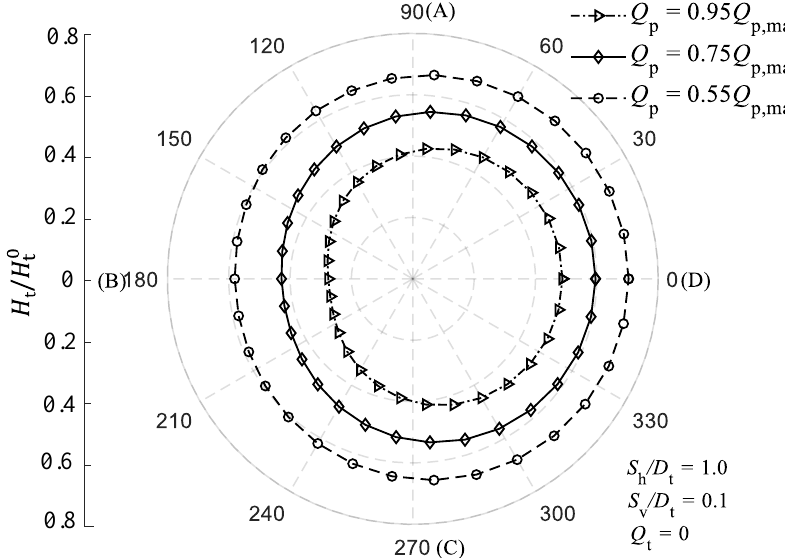
Figure 14. Relative pressure head at tunnel boundary.